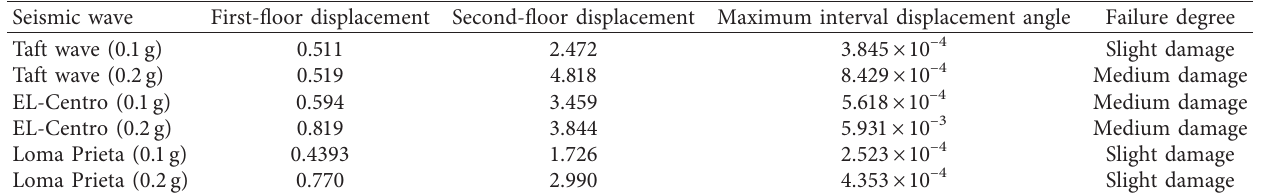
Table 10: Maximum displacement (mm), maximum interval displacement angle, and failure degree of the structure after reinforcement. Seismic wave